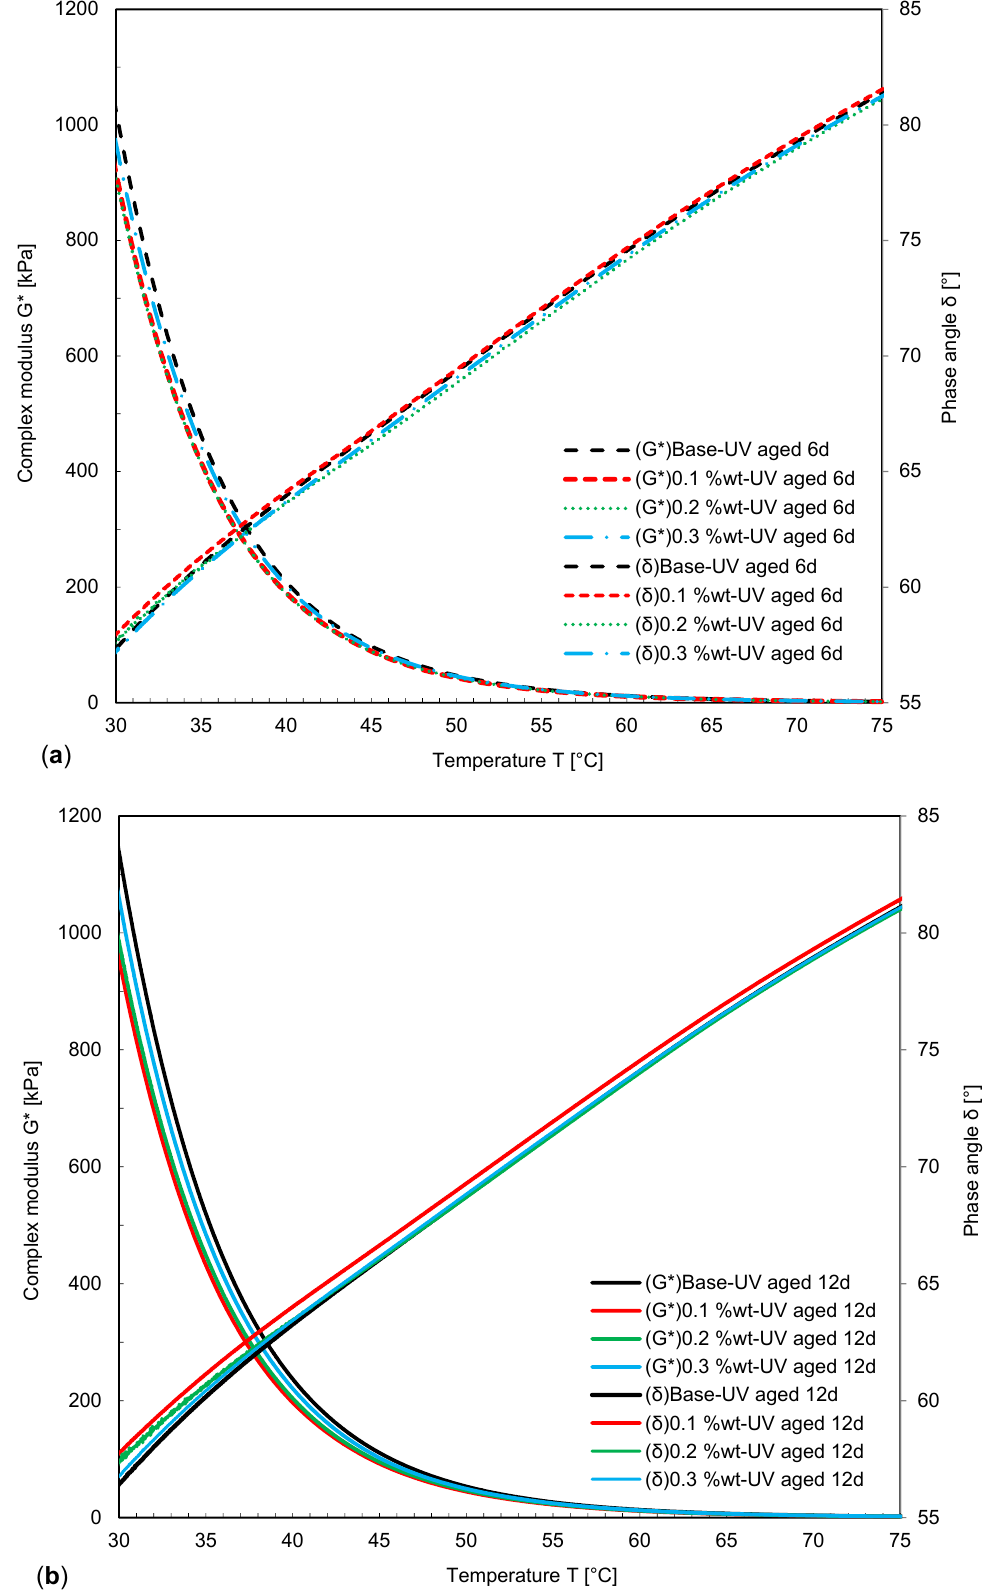
Figure 7. Complex modulus and phase angle of modified bitumen with NPs after ( a ) 6 days of UV aging and ( b ) after 12 days of UV aging.